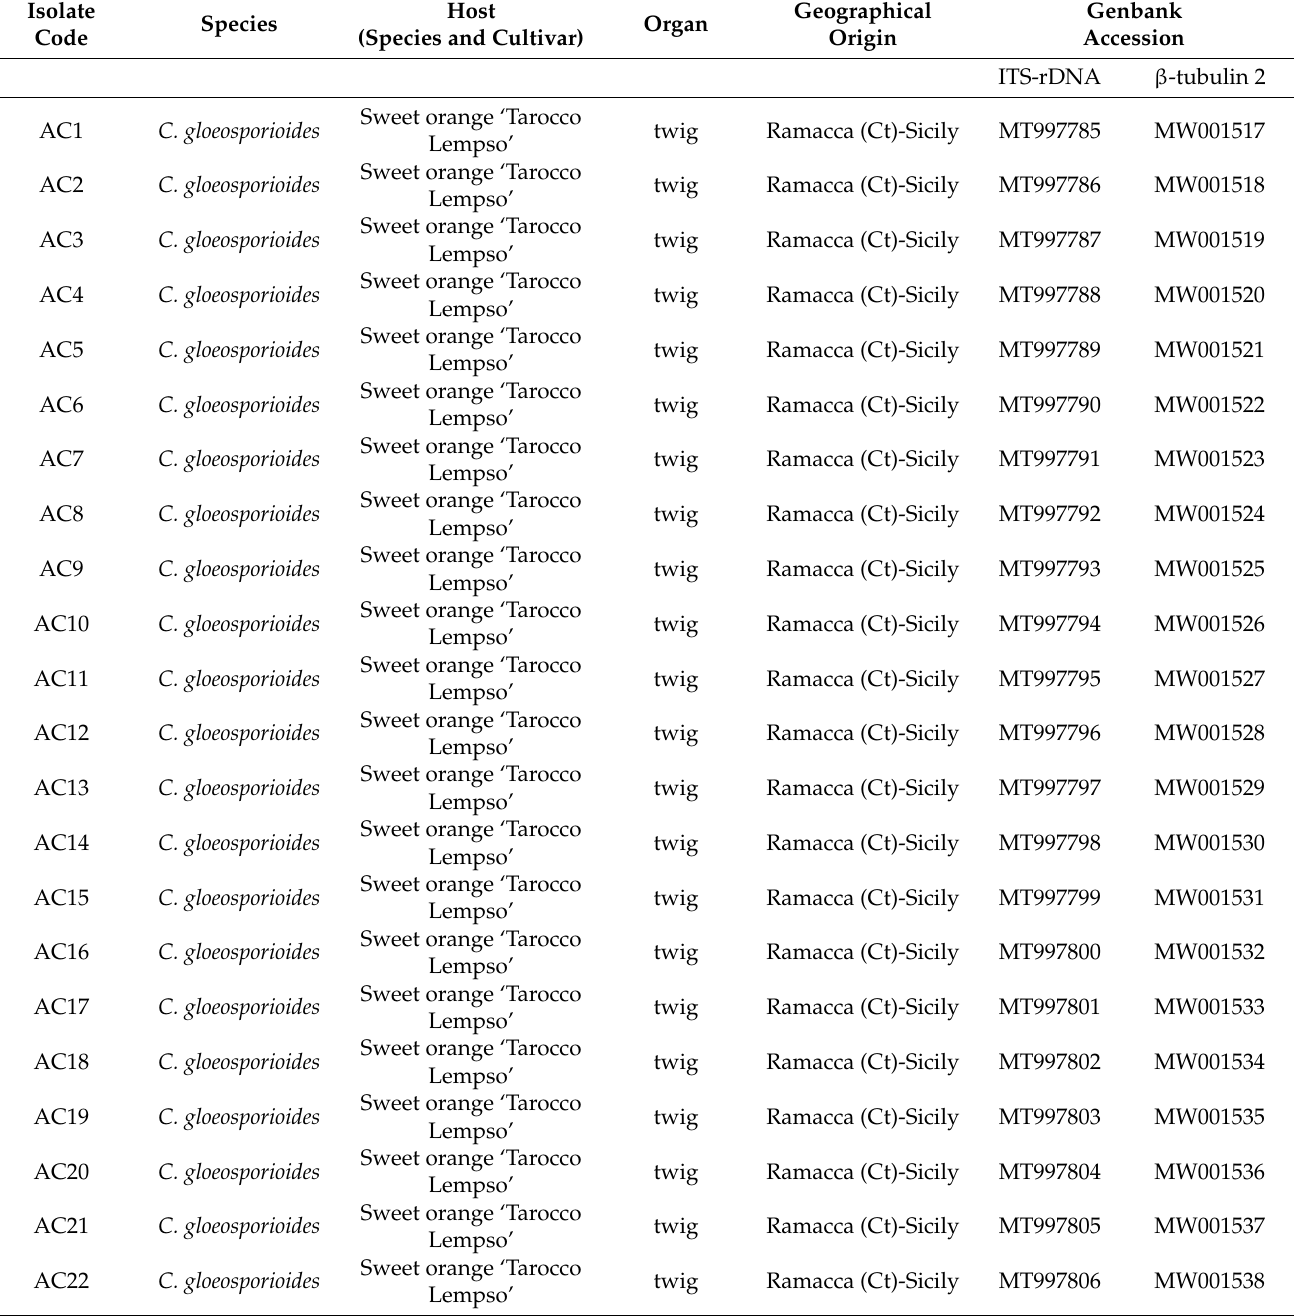
Table 1. Isolates of Colletotrichum sourced from different cultivars of Citrus species in Sicily (southern Italy) and Albania and characterized in this study. * Tetraploid hybrid clementine ‘Nules’x sweet orange ‘Tarocco’. Isolate